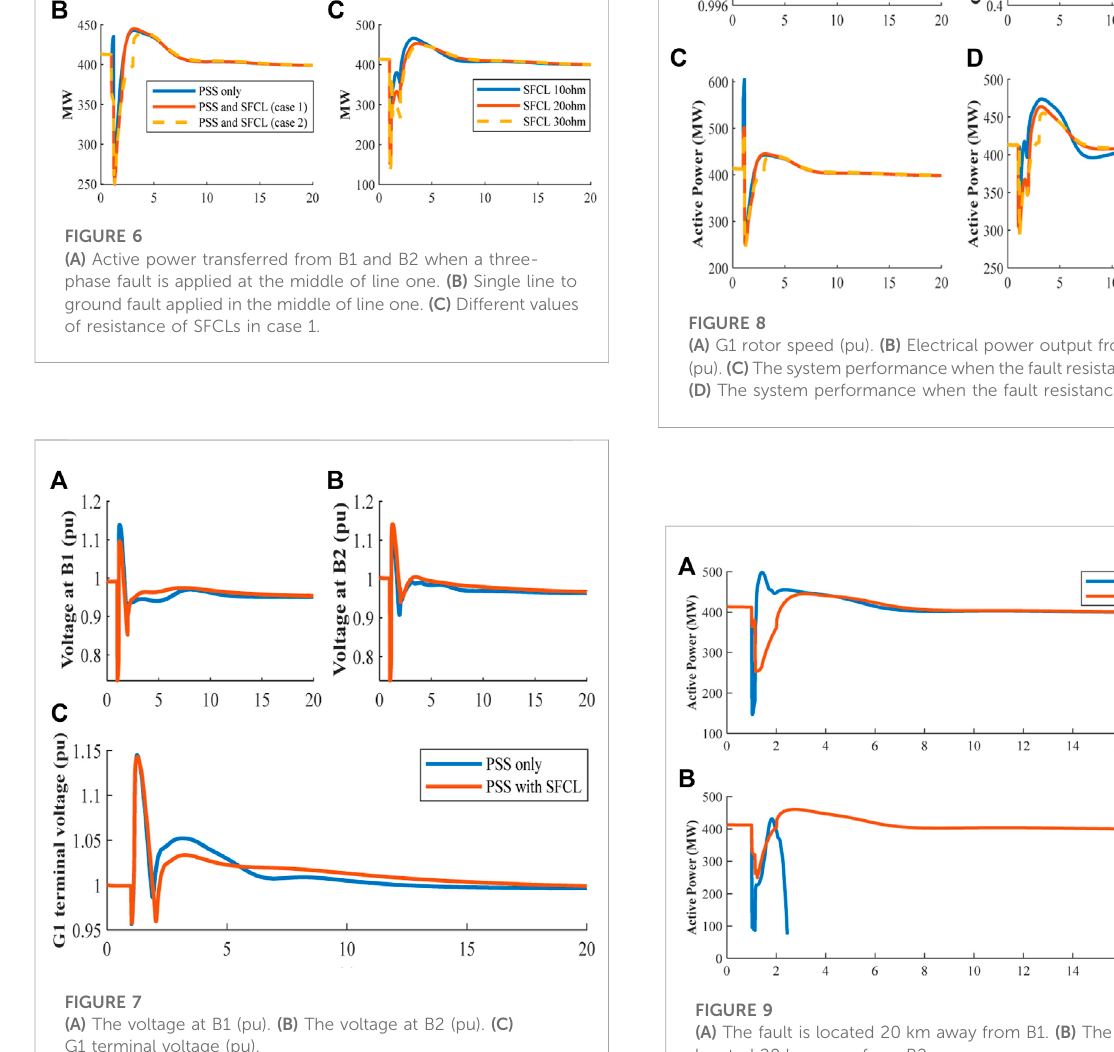
FIGURE 7 (A) The voltage at B1 (pu). (B) The voltage at B2 (pu). (C) G1 terminal voltage (pu).